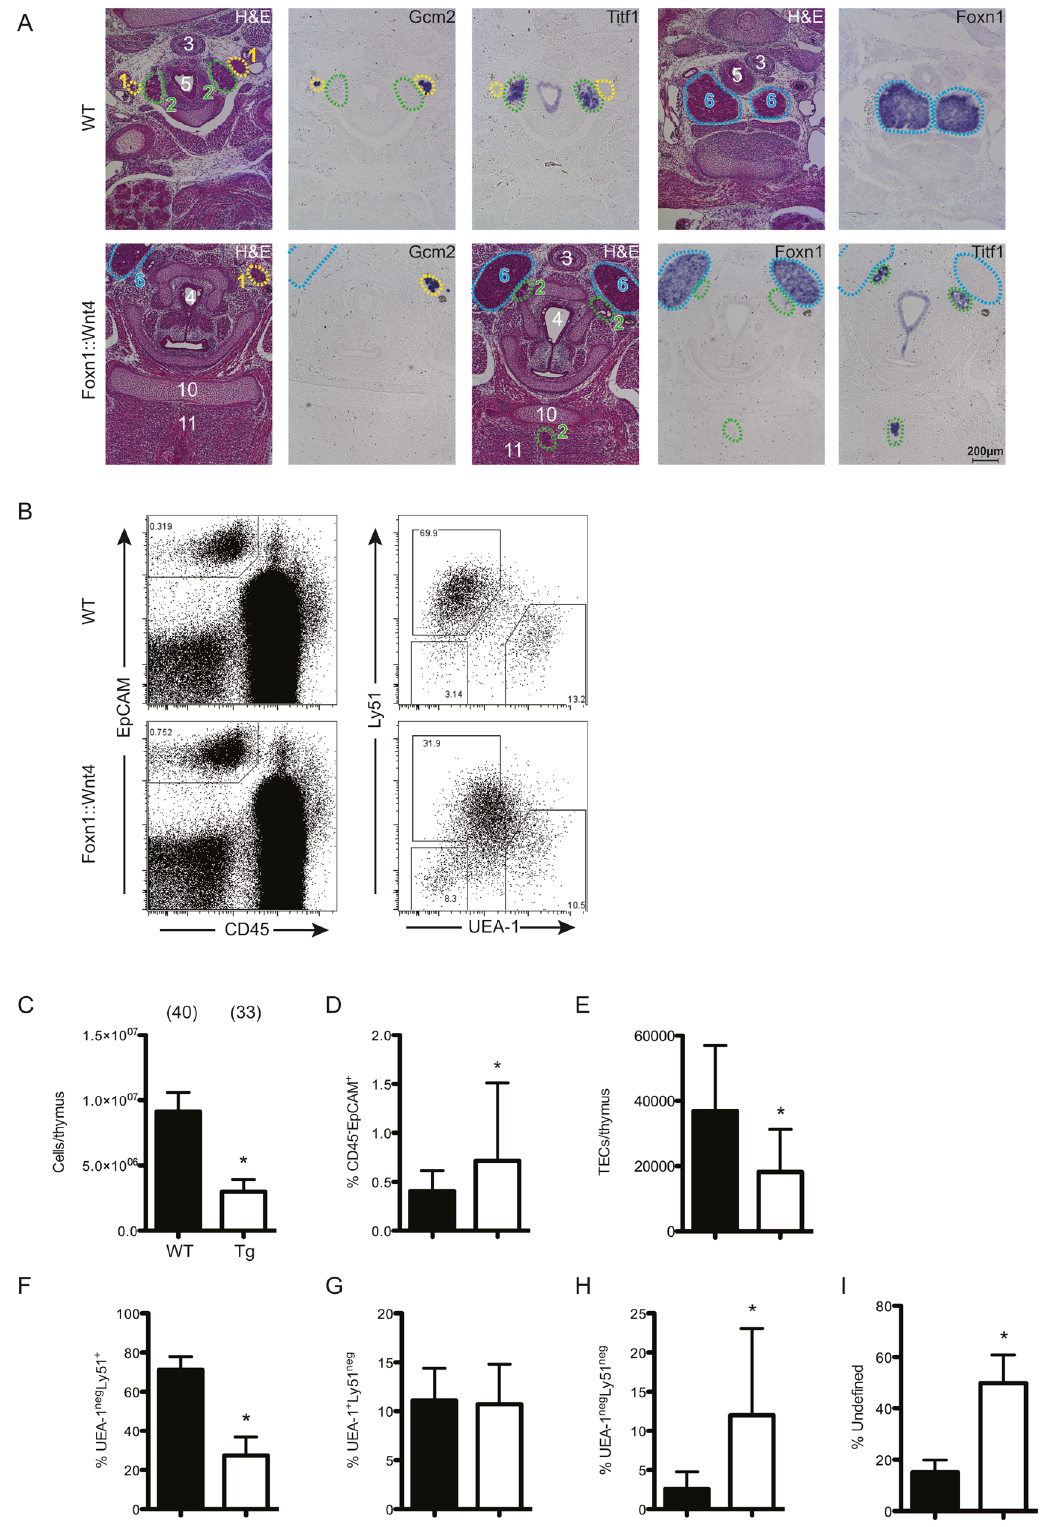
Figure 5. Wnt4-overexpression disrupts thymus migration and TEC differentiation. ( A ) Development of wild- type mice at E15.5 examined by H&E staining and RNA in situ hybridization with the indicated gene-specific probes ( Gcm2 [parathyroid], Titf1 [thyroid] and Foxn1 [thymus]). ( B – I ) Flow cytometric analysis of TECs from newborn wild-type and Foxn1::Wnt4- transgenic mice. ( B ) Representative gating of EpCAM + TECs. Gates defining UEA-1 neg Ly51 + , UEA-1 + Ly51 − and UEA-1 neg Ly51 neg populations are depicted; events falling outside of these gates are classified as “undefined”. ( C – I ) Cell numbers and proportions of various TEC subsets (wild-type, black bars; open bars, Foxn1::Wnt4 -transgenic mice). Means ±